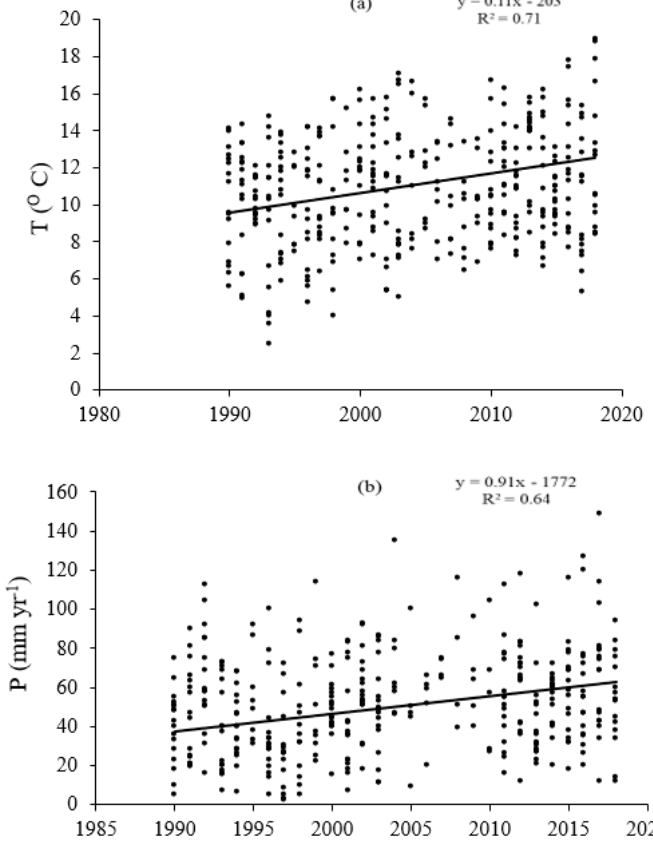
Figure 5. Distribution of mean monthly surface air temperature T °C ( a ) and precipitation P (mm yr − 1 ) ( b ) for a 28-year period (1990–2018) on the territory of the Kola North; dots are values, lines are trends.